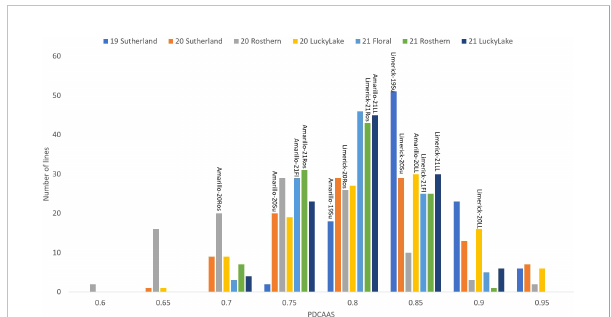
FIGURE 7 Frequency distribution of PDCAAS of PR-25 across seven station- years based on the average of biological replicates for each line in each station-year (two biological replicates in 2019 Sutherland and three biological replicates for the rest of the station-years), and the averaged PDCAAS for the parents of PR-25 in each station-year.